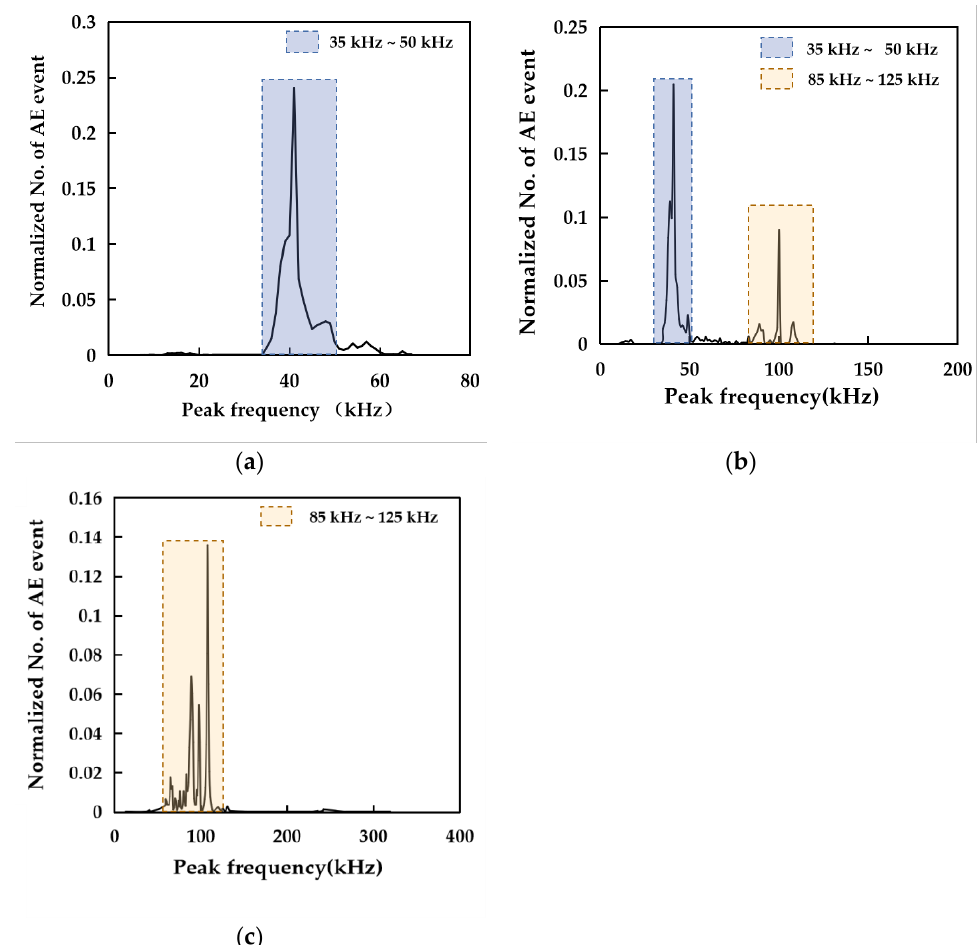
Figure 11. Peak frequency distribution of three clusters: ( a ) cluster 1; ( b ) cluster 2; ( c ) cluster 3.